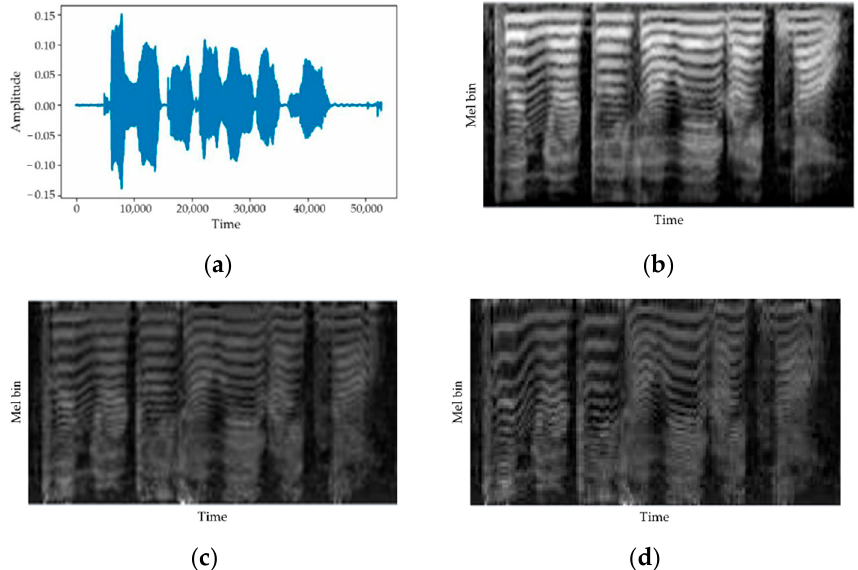
Figure 8. Waveform and Mel-spectrograms. ( a ) Waveform of the input signal, ( b ) Mel-spectrogram of the input signal, ( c ) reconstructed Mel-spectrogram, and ( d ) converted Mel-spectrogram.